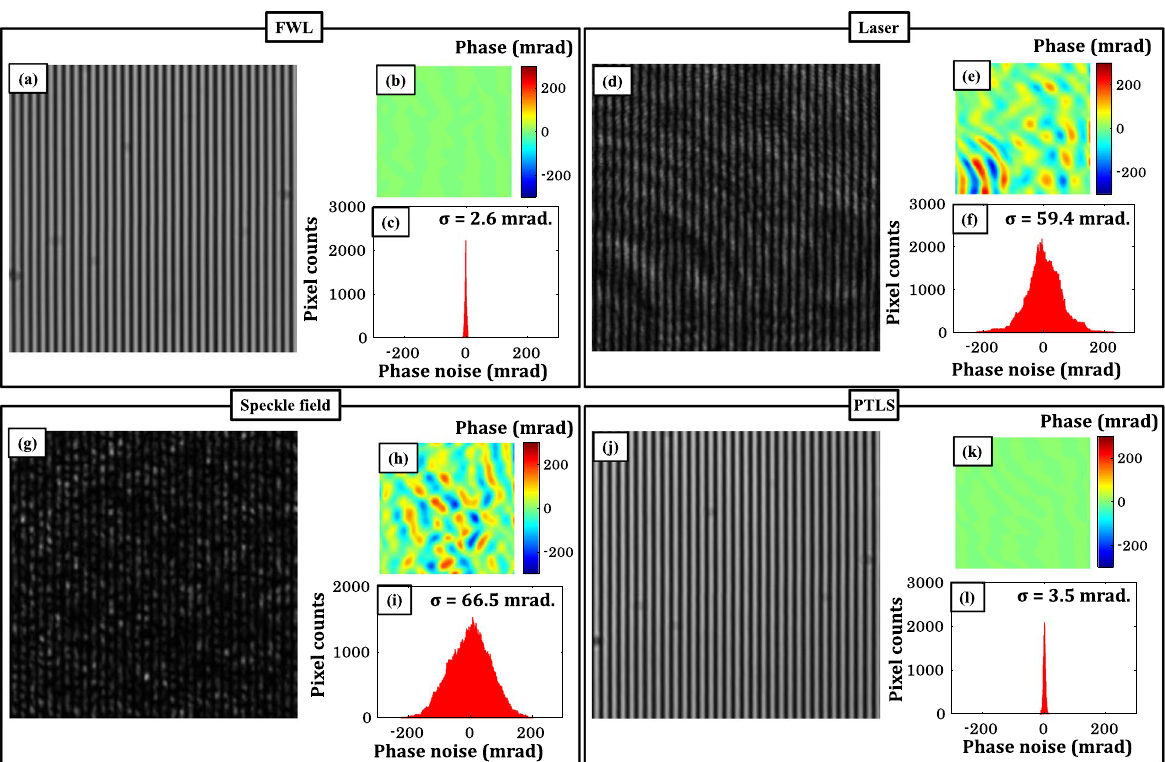
FWL : Filtered white light; PTS: Pseudo-thermal light source Figure 3. PTLS prevents speckle noise formation. Four differently generated light sources were used: filtered white light, narrow band laser, speckle field and pseudo-thermal light source. A bandpass filter of 10 nm bandwidth at central wavelength 632 nm is inserted into the white light beam path to generate FWL. Speckle field is generated by passing a narrow band laser beam through a stationary diffuser. PTLS is synthesized by passing a highly temporal coherent beam through a rotating diffuser followed by a multimode fiber. ( a , d , g , j ) Interferometric images of a standard Si wafer. ( b , e , h , k ) Corresponding reconstructed phase images while employing FWL, laser, speckle field and PTLS, respectively. ( c , f , i , l ) Histograms of the recovered phase images of Si wafer to illustrate the spatial phase noise while using aforementioned light sources. The PTLS effectively suppressed spatial phase noise, behaving similarly to the FWL but very differently from conventional lasers. The color bars are in mrad.